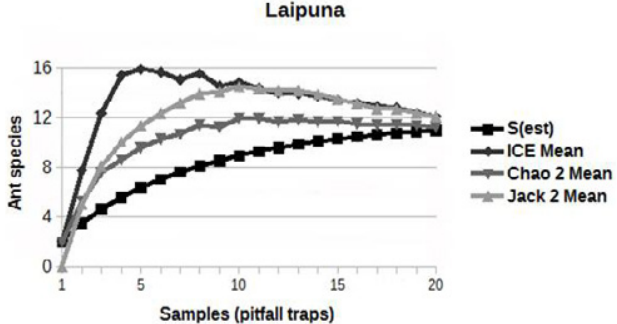
Fig 2 . Species accumulation curve and estimator curves for the Laipuna Reserve dry forest.